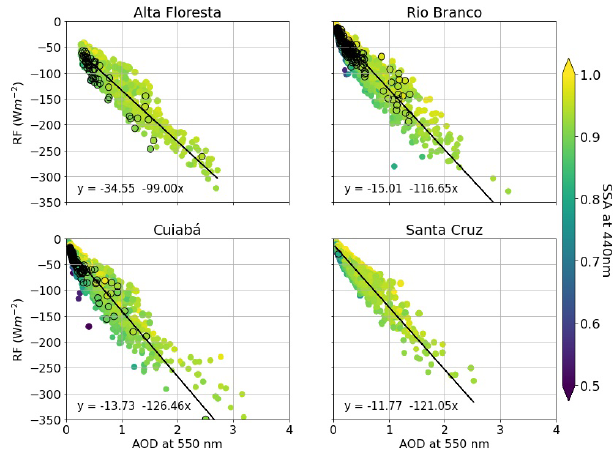
Figure 7. Aerosol direct instantaneous radiative forcing as func- tion of AOD at 550nm at AERONET sites highlighting 2020 values (black) against historical values